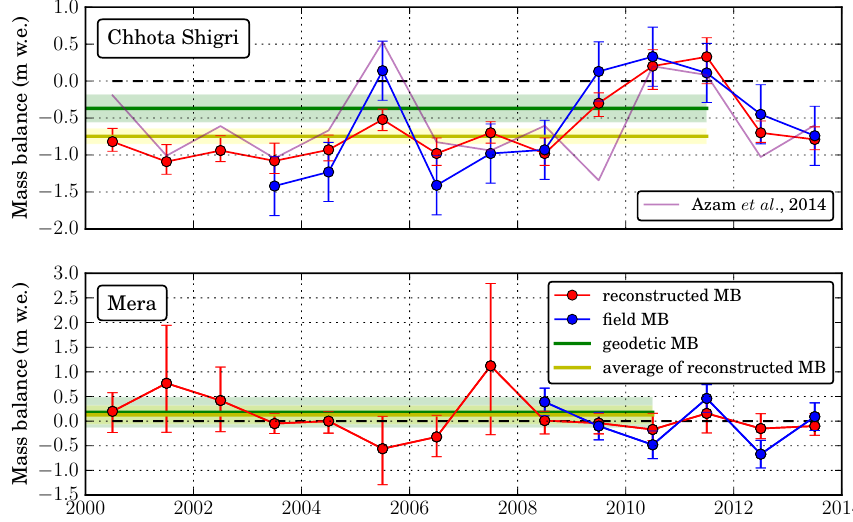
Figure 10. Reconstructed mass balance for Chhota Shigri (top) and Mera (bottom) glaciers. The green and yellow lines represent the annual mean of the geodetic mass balance from Gardelle et al. (2013) and the annual mean of the reconstructed mass balance, respectively. The purple line corresponds to the annual mass balance values calculated with a degree-day model (Azam et al., 2014a). The error bars for the reconstructed mass balance correspond to the 90% confidence interval. For Mera Glacier some reconstructed mass balance values (for the years 2001 and 2007) correspond to albedo values outside the range of calibration and are therefore believed to be questionable. Note that the scaling of mass balance is different on both